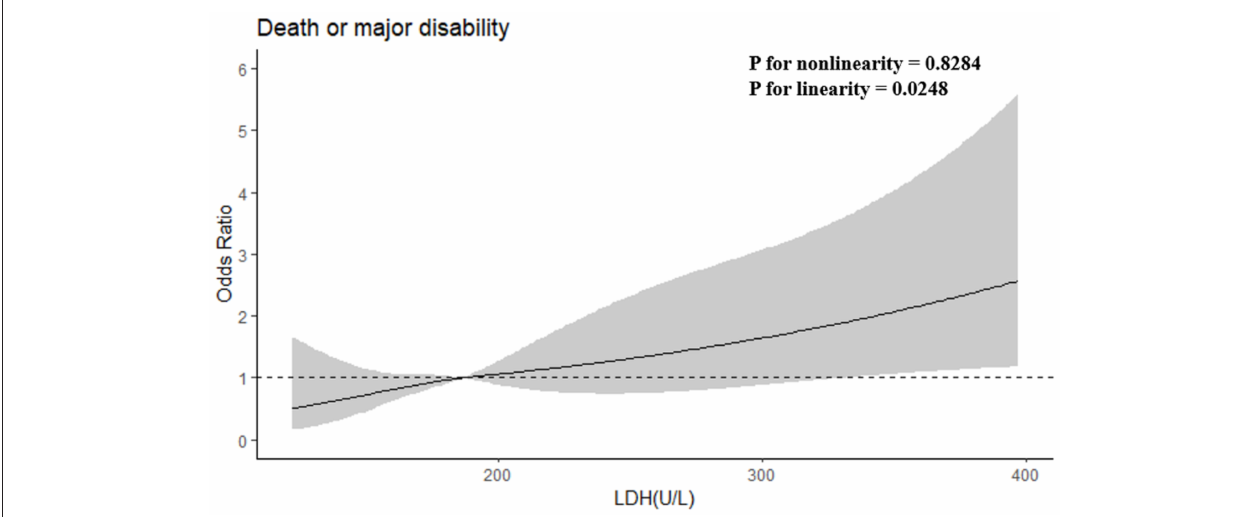
FIGURE 1 | Adjusted odds ratios of primary outcome according to serum LDH. OR and 95% CI derived from restricted cubic spline regression, with knots placed at the 5th, 35th, 65th, and 95th percentiles of LDH. OR adjusted for the same variables as model 2 in Table 2 .